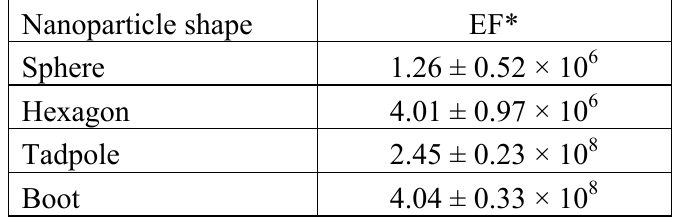
Table 1. Calculated Surface Enhancement Factors (EF) for SCN - on ITO Glass Slices Assembled with Gold Nanoparticles of Different Shapes